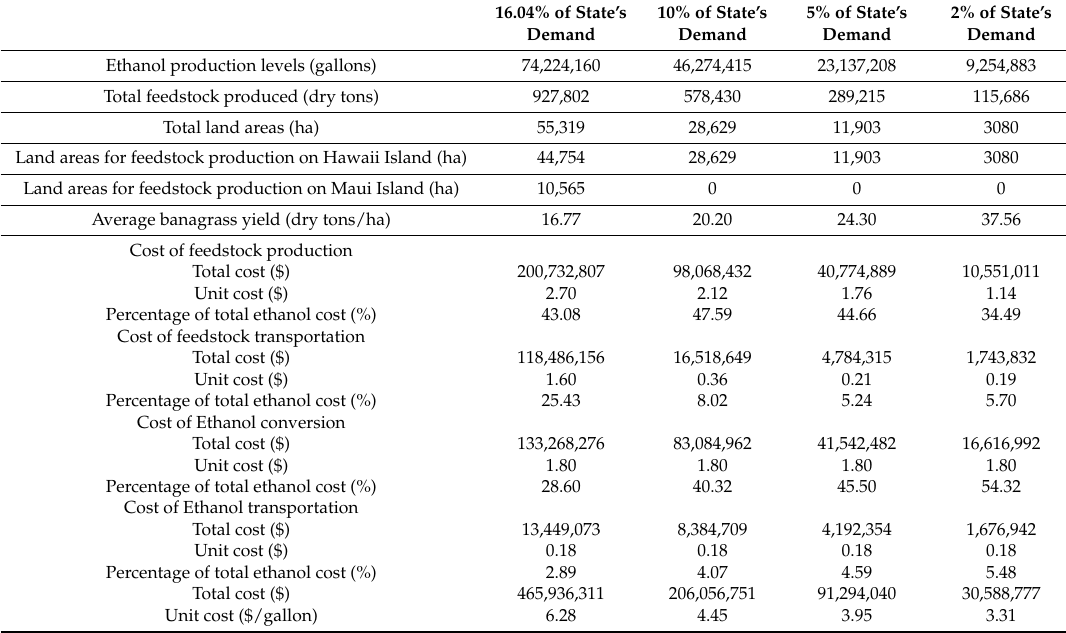
Table 5. Cost analysis of ethanol production for ethanol processing plant